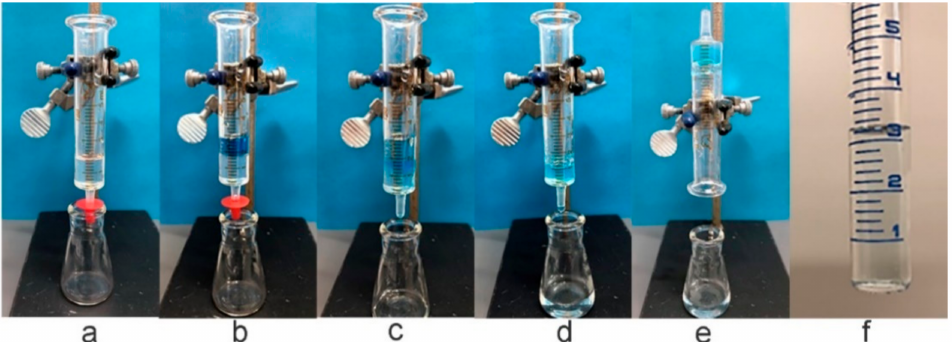
Figure 13. Gel column for the dye absorption experiment. ( a ) Gel column before the experiment; ( b ) Gel column after loading with 1 mL of 32.7 µ M TBO stock solution; ( c ) Washing the column with 1 mL of DI water; ( d ) Gel column at the end of the experiment; ( e ) Inverted gel column after the completion of the experiment; ( f ) Very light blue aqueous solution collected from the gel